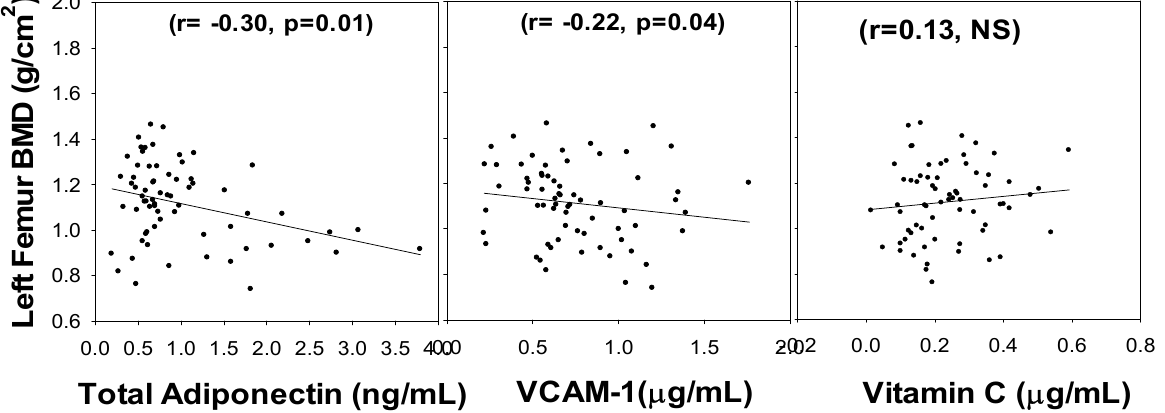
Figure 2. Correlation of Left Femur BMD with blood levels of total adiponectin, VCAM-1, and vitamin C in subjects with diabetes. NS, not-significant. p -values were determined using multiple regression analyses and controlling for BMI and duration of diabetes.